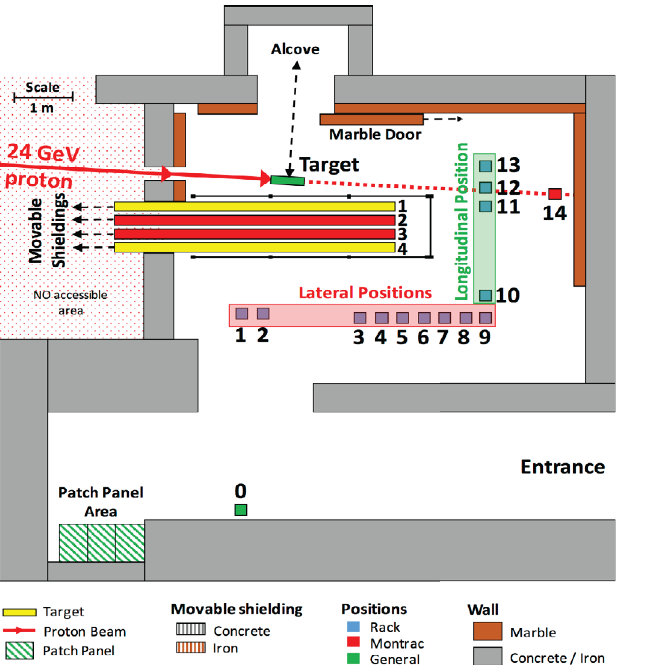
Fig. 1. CHARM test facility model, top view.